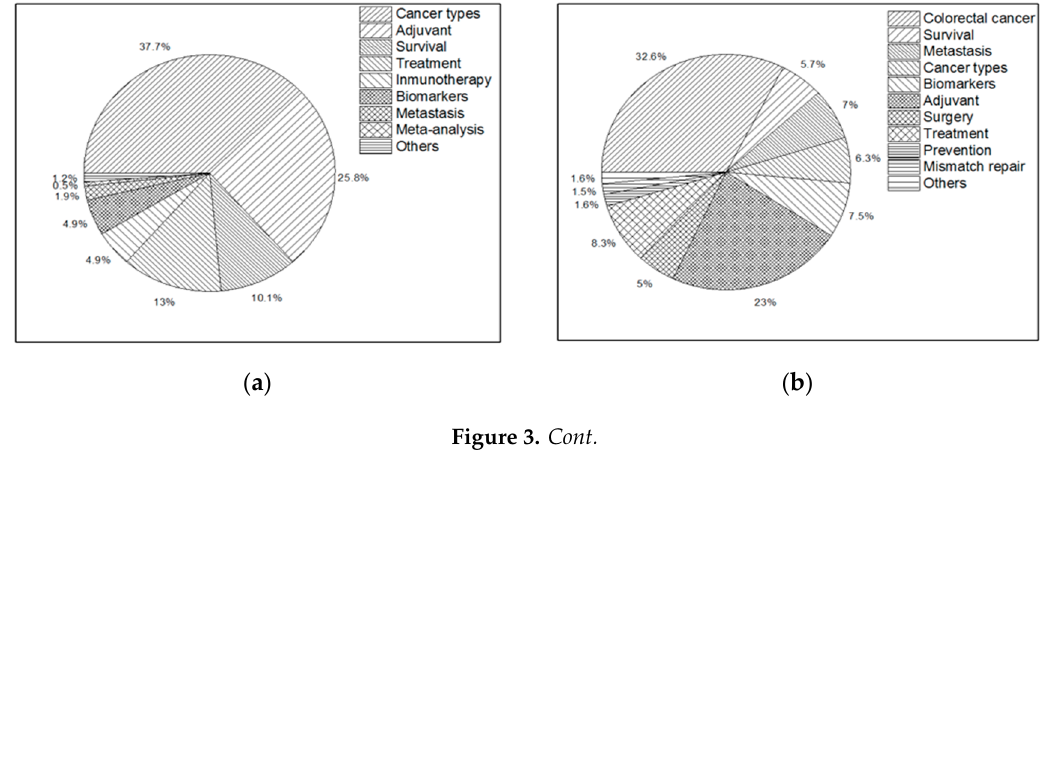
Table 1. Comparison of keyword groups in scientific papers for cancer adjuvants and colorectal cancer adjuvants. Two thousand papers were extracted from Scopus and examined in their keywords and the documents up to 31/12/2018; the keywords were grouped using